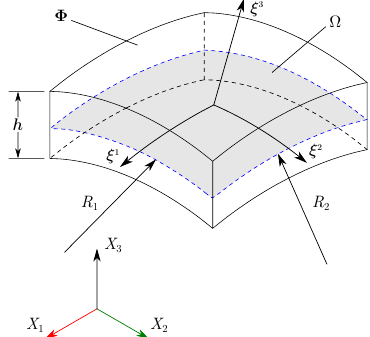
Figure 1. Shell element and its mid-surface.